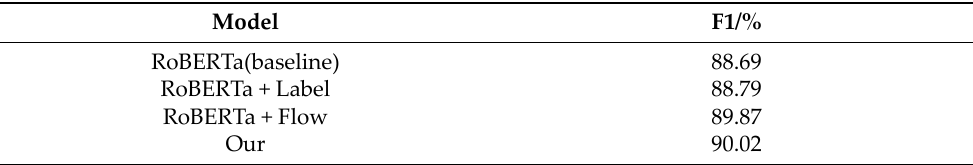
Table 7. Results of the ablation